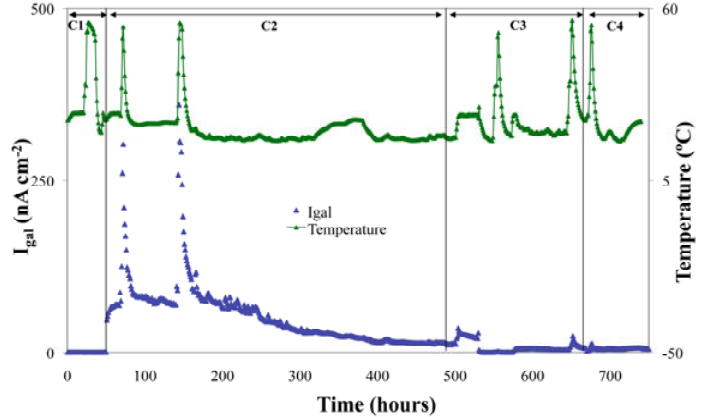
Figure 4. I and temperature vs . immersion time for the conditions C1 to C4. gal